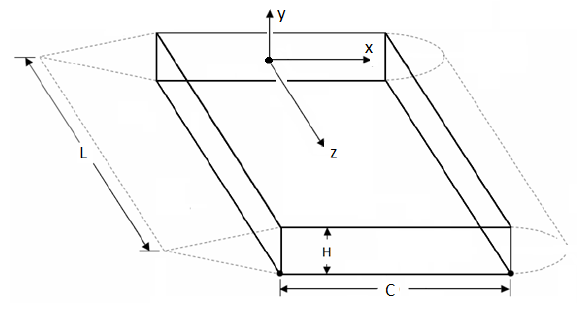
Fig. 1. Generic wing , notations and coordinate